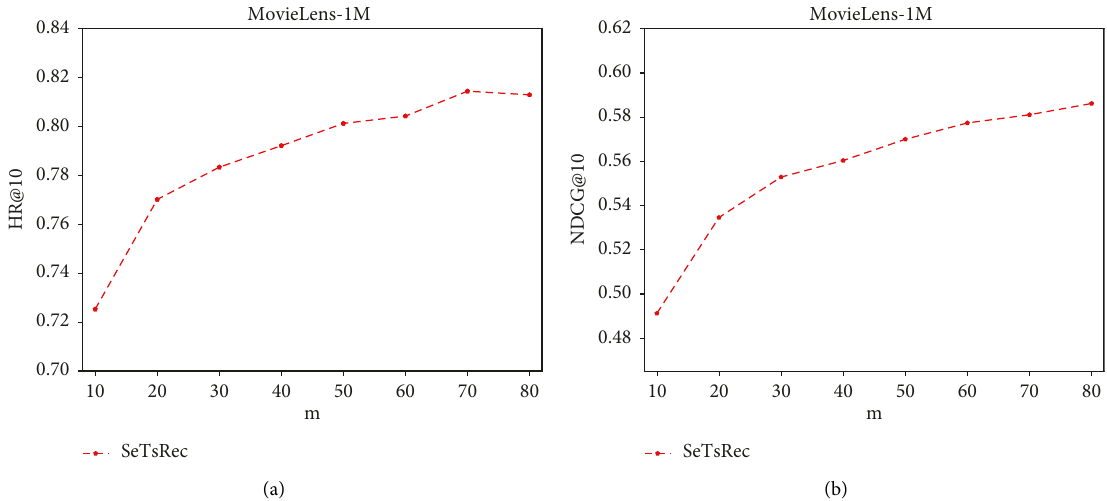
Figure 8: Experiment results of different maximum sequence length m on ML-1M. (a) Results on HR@10. (b) Results on NDCG@10.